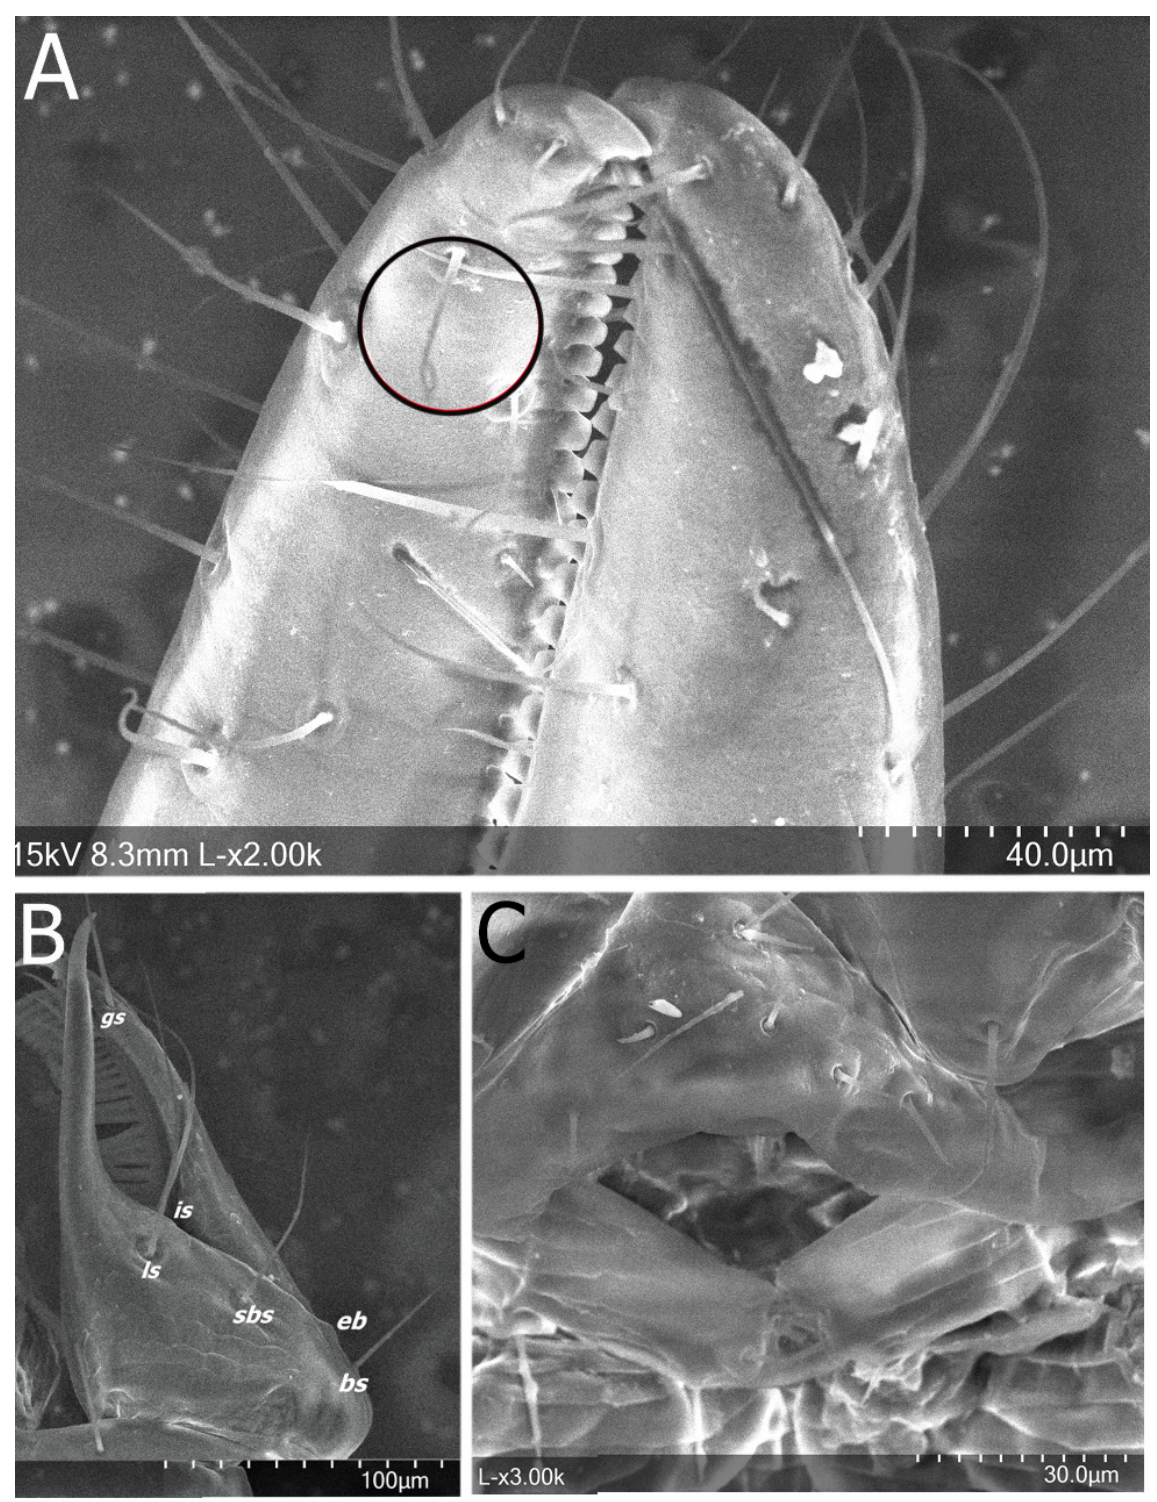
Fig. 22. Scanning electron micrographs of Ideoblothrus nadineae sp. nov., paratype, ♂ (ZMH A0003695). A . Close-up view of chela, showing lanceolate trichobothrium t . B . Chelicera in dorsal view, showing trichobothria. C . Genital